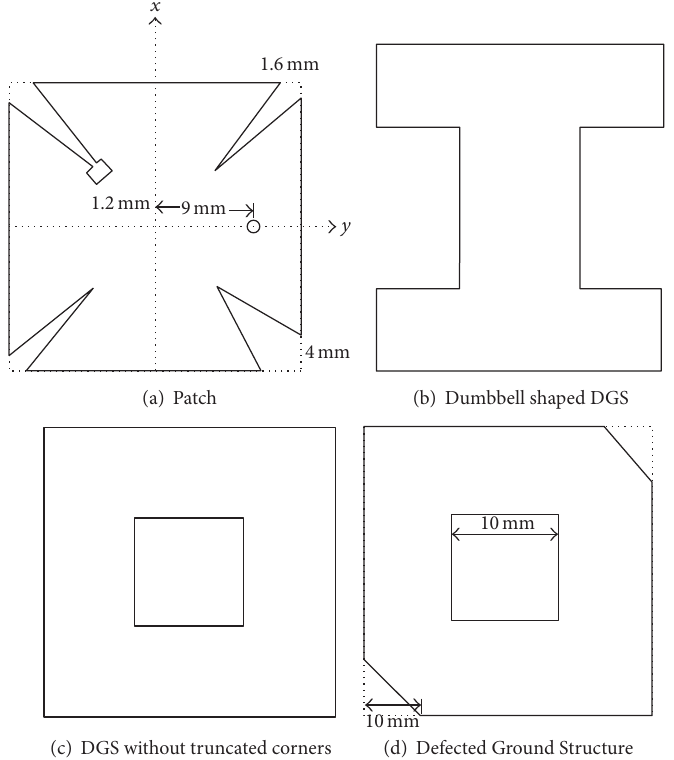
Figure 26: Geometry of the dual-band circularly polarized asymmetric slit microstrip antenna with DGS